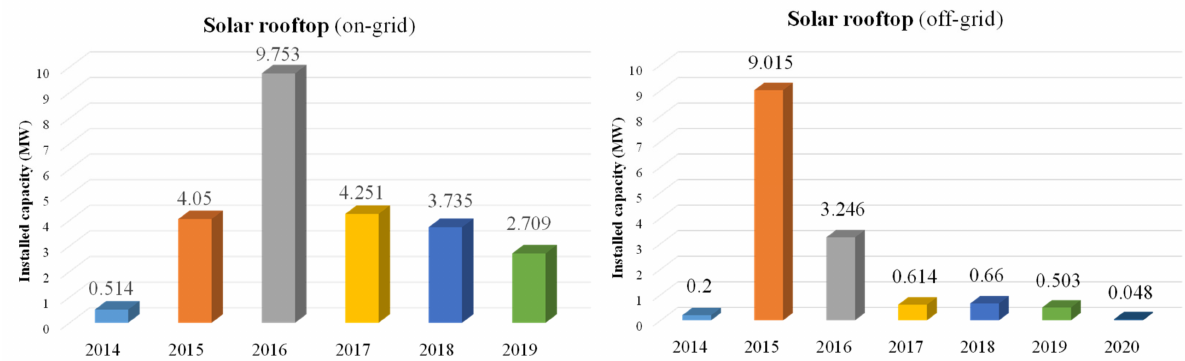
Figure 14. Historical yearly net installed capacity of on-grid and off-grid solar rooftops (authors’ creation based on SREDA data